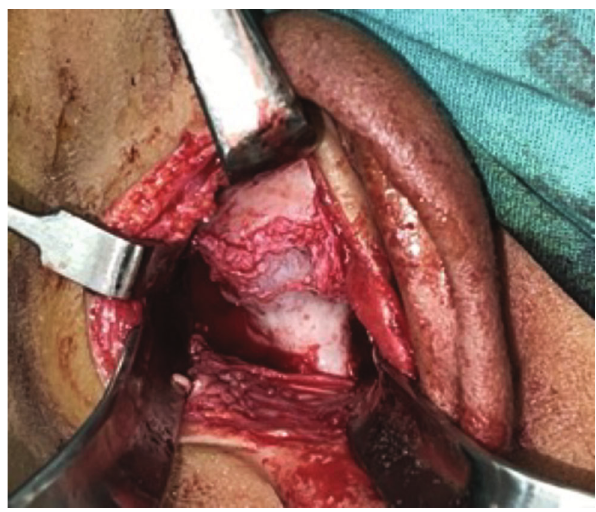
Figure 6: An intra-operative view of the ankylotic mass.